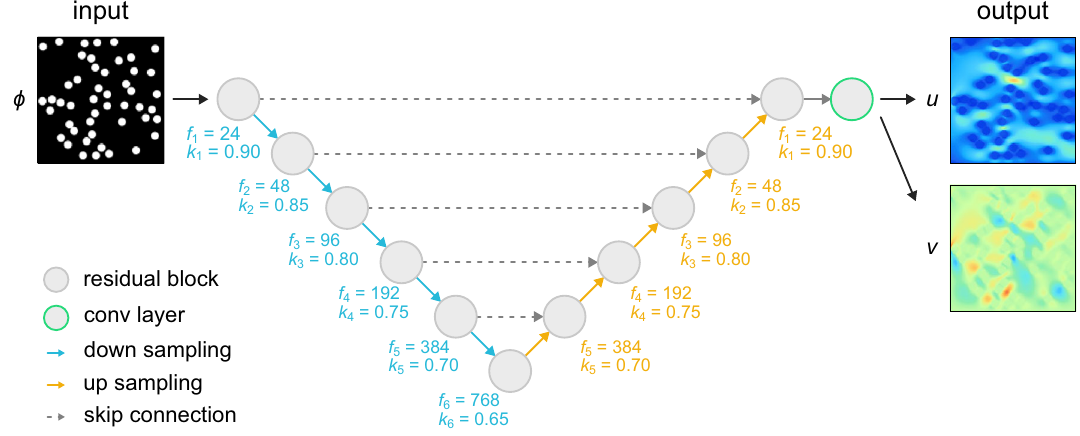
Figure 2. Schematic representation of the architecture of the deep-learning model. The input is a smoothed profile function φ , and the outputs are the x - and y -components of the flow velocity (i.e., u and v ). The filter size f i and keep probability k i of i th residual block are